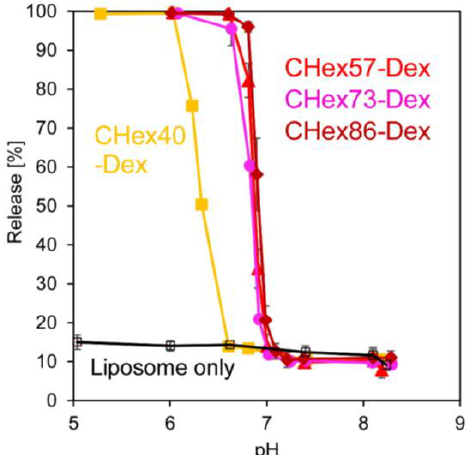
Figure 5. pH-Dependence of pyranine release from liposomes after addition of various dextran derivatives at various pH and 37 °C. Content release after 30 min-incubation is shown. Lipid concentration was 2.0 × 10 −5 M. The ratio by weight of lipid: polymer is 9:1.